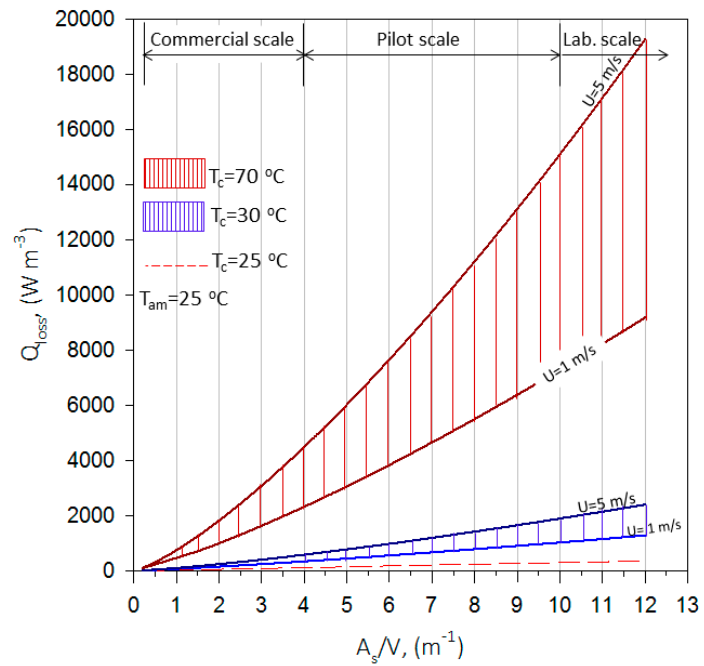
Figure 4. Heat loss per unit volume of the bioreactor, estimated at different composting temperatures ( T c ) as affected by ambient air speed (1–5 m s –1 ) and A s / V ratio.